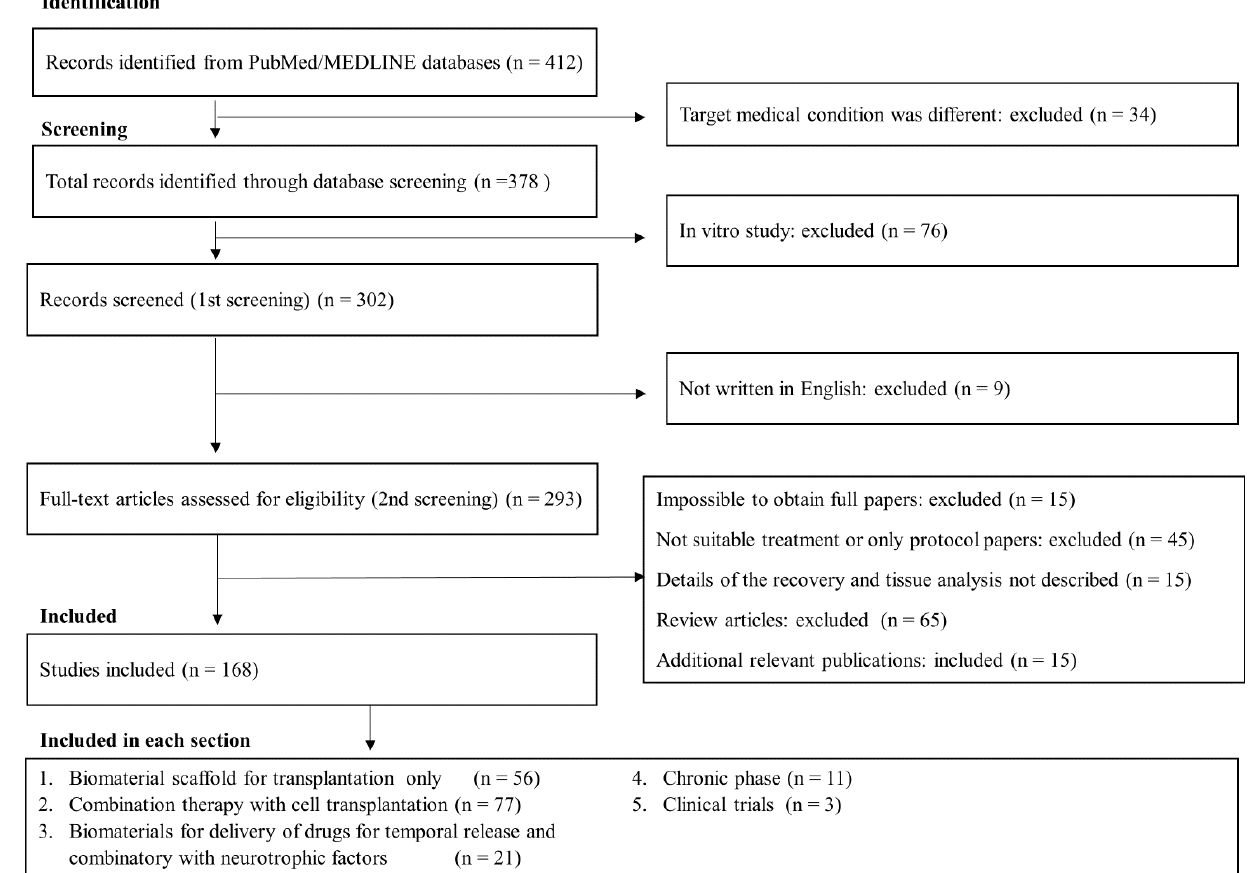
Figure 3. Flowchart of the screening process in this systematic